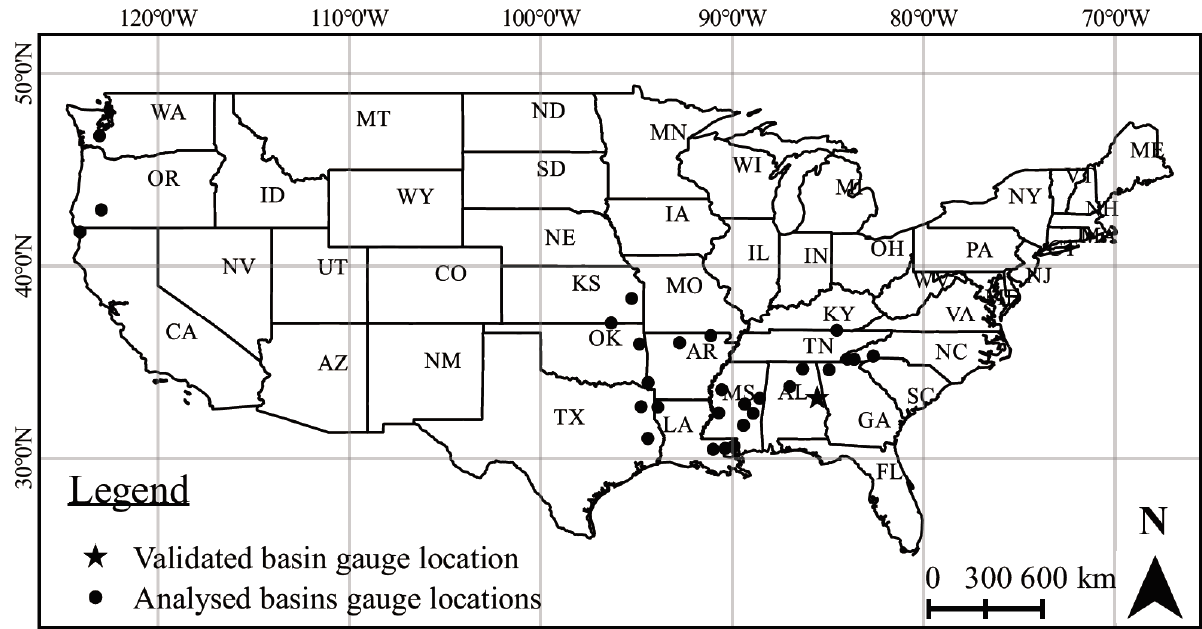
Figure 1. Stream gauge location map over the USA